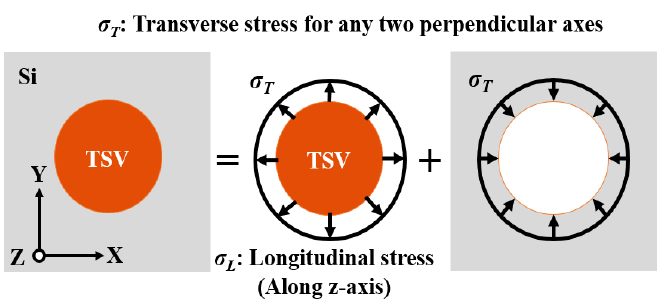
Figure 1. Schematic of Lamé radial stress solution based on the superposition principle. The stress field is integrated by the intrinsic stressed TSV core and reacted stress from the surrounding Si substrate.